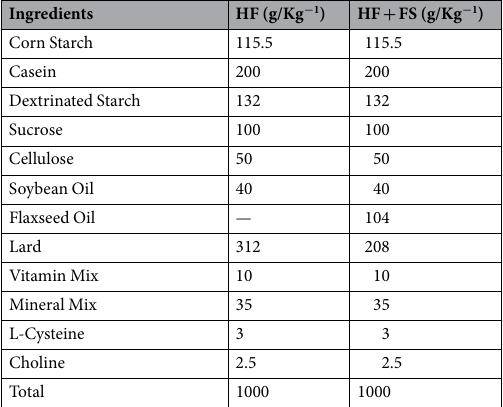
Table 2. The Composition of the Experimental Diets. Diet based on AIN-93 G – American Institute of Nutrition 47 . HF –